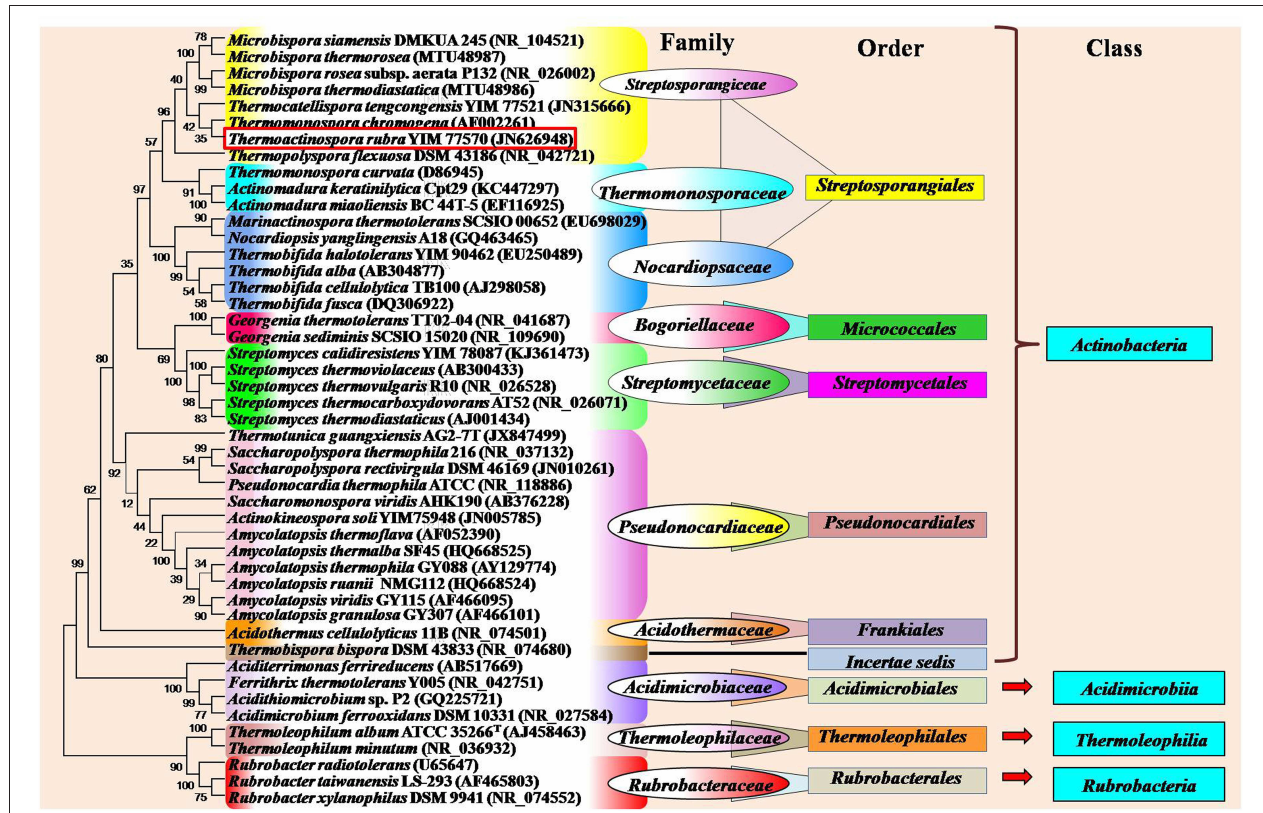
FIGURE 1 | Phylogram indicating the placement and relatedness of some thermophilic and thermotolerant actinobacterial strains belonging to four classes ( Actinobacteria , Acidimicrobiia , Rubrobacteria , and Thermoleophilia ) of the phylum Actinobacteria . The numbers given at branch nodes indicate (%) bootstrap value. Phylogenetic tree was generated using Mega5.2 software with 1000 bootstrap replications. Bar 0.02 substitutions per 100 nucleotide